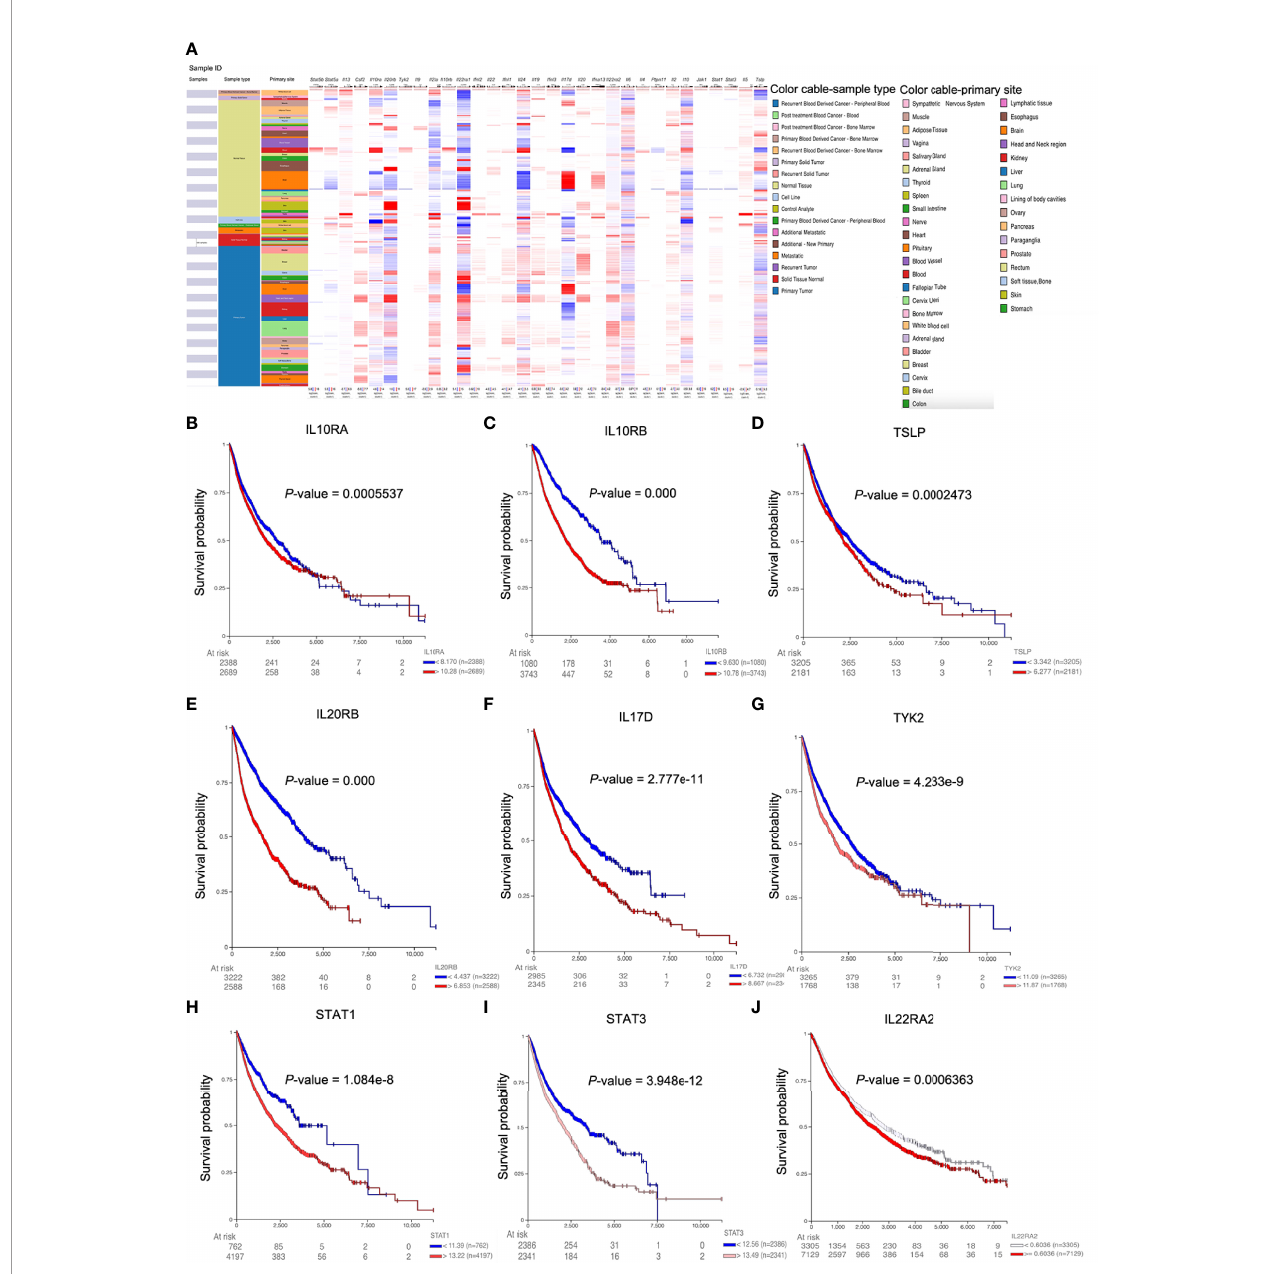
FIGURE 3 | Higher expression of IL22RA1-associated genes correlates with overall survival in patients. (A) Heatmap shows the expression of IL22RA1 and IL22RA1-related genes in tumor and normal tissues from TCGA/TARGET/GTEx. (B – J) In fl uence of the expression of indicated genes on overall survival rate based on UCSC Xena web-based